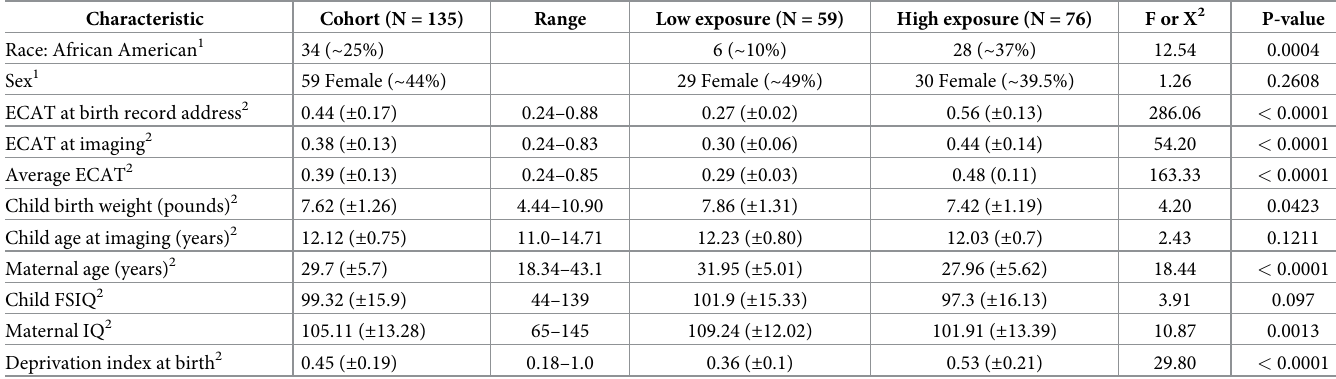
Table 2. Model variables evaluated in the nested imaging substudy cohort.